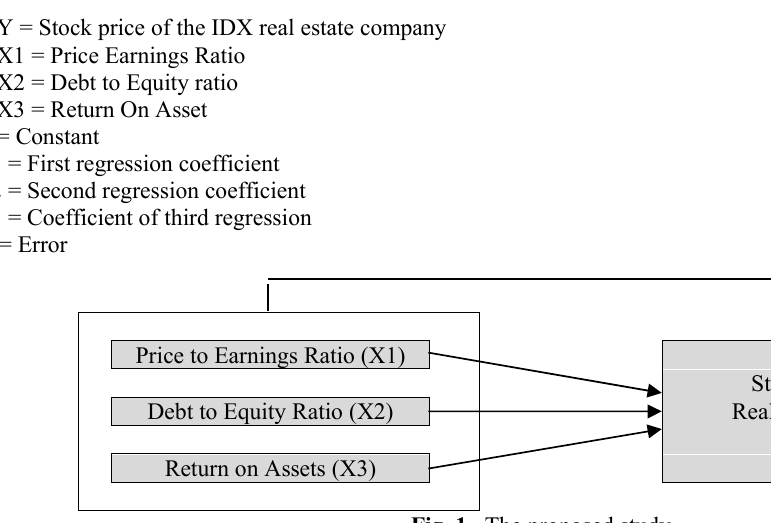
Fig. 1. The proposed